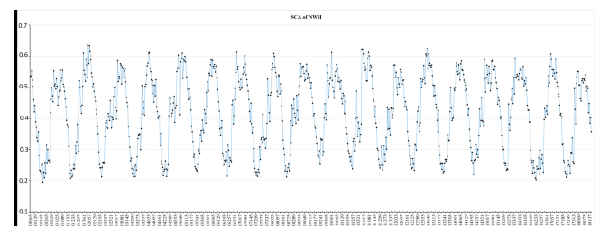
Figure 8. Surface water occurrence of NWH from 1984 to 2015